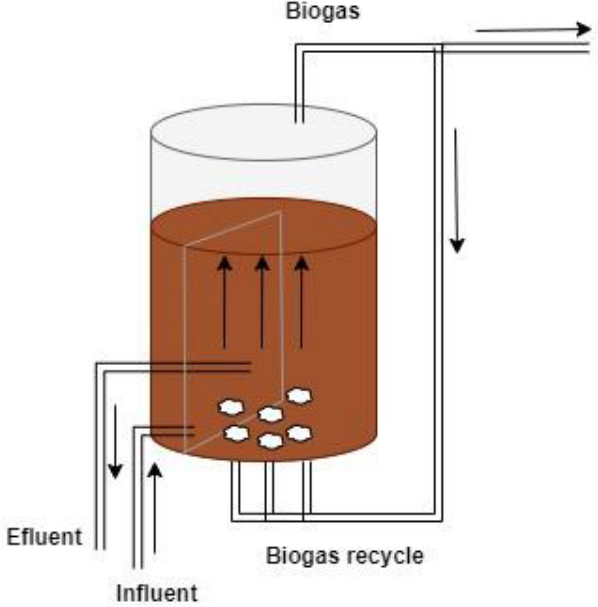
Figure 8. The reactor that provides the Strabag process.